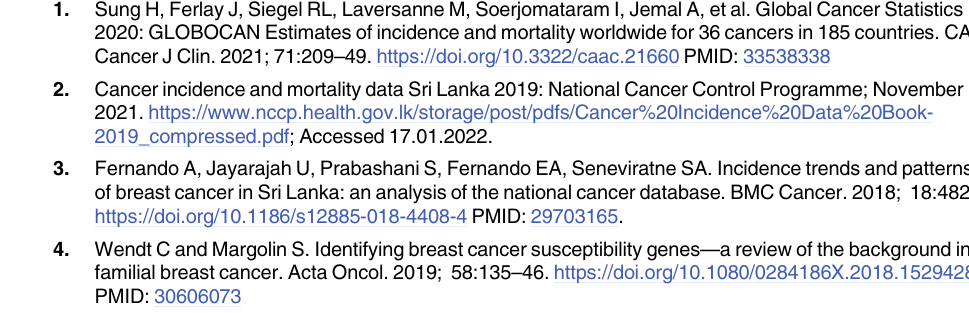
S8 Table. List of